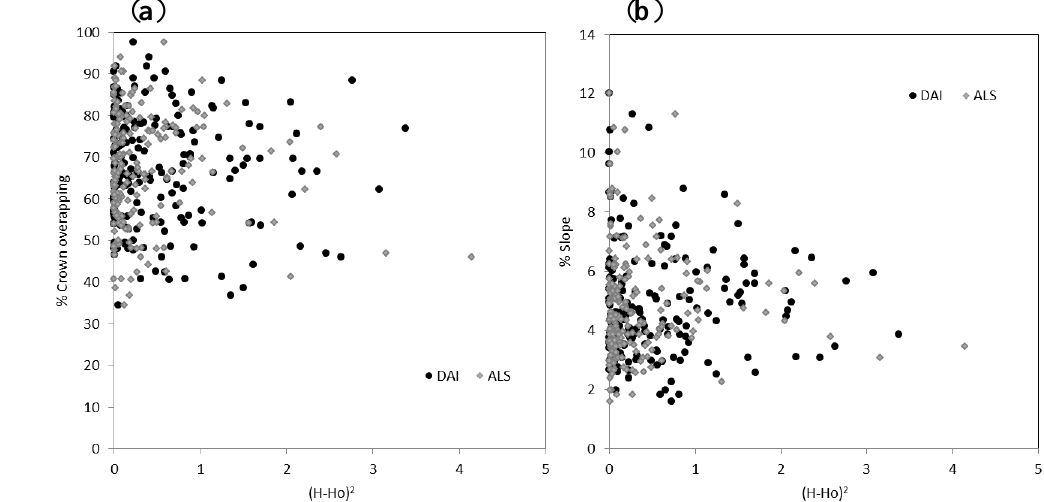
Figure 7. ( a ) Difference between predicted and observed height (H − Ho) 2 in relation to the percentage of crown overlapping using the DAI-based canopy height model and ALS data.